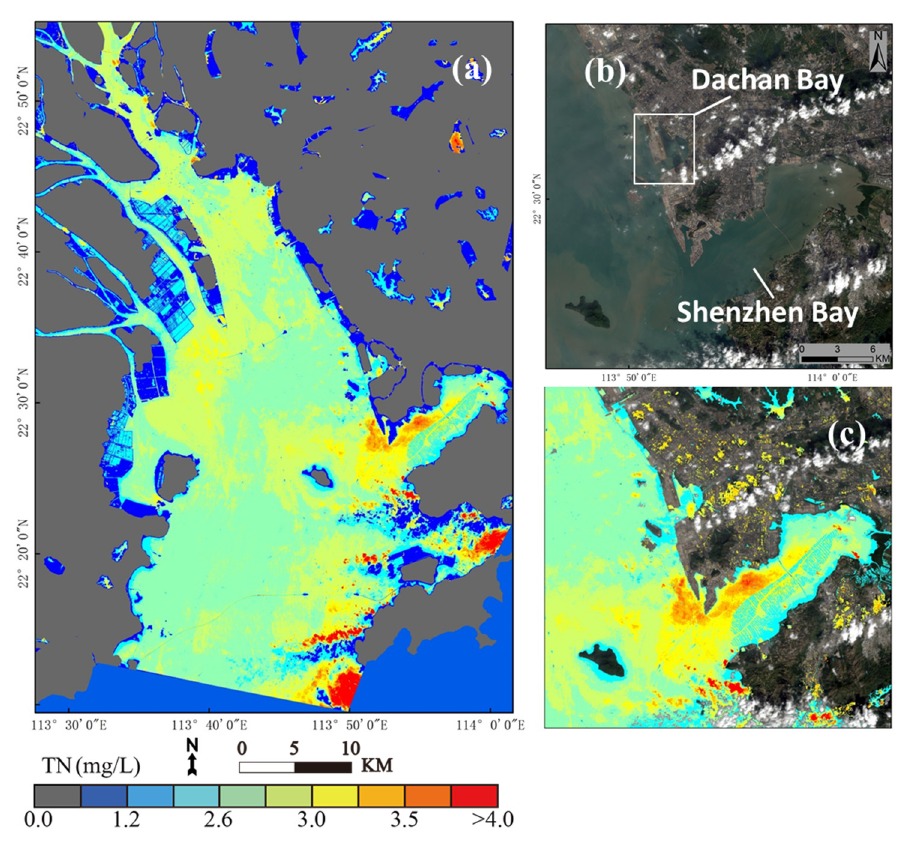
Figure 5. TN concentrations in the PRD. ( a ) The whole PRD area. ( b ) Dachan Bay and Shenzhen Bay. ( c ) TN concentration in Dachan Bay and Shenzhen Bay.